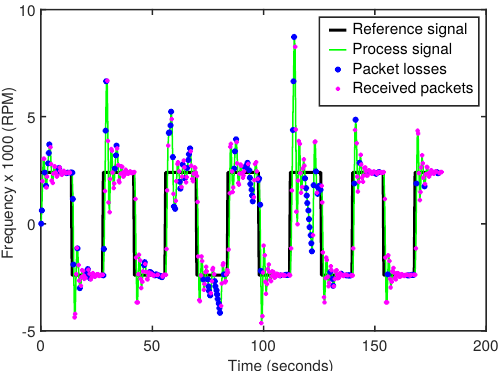
Figure 11. Unstable process operation (compromised) with 30% of packet